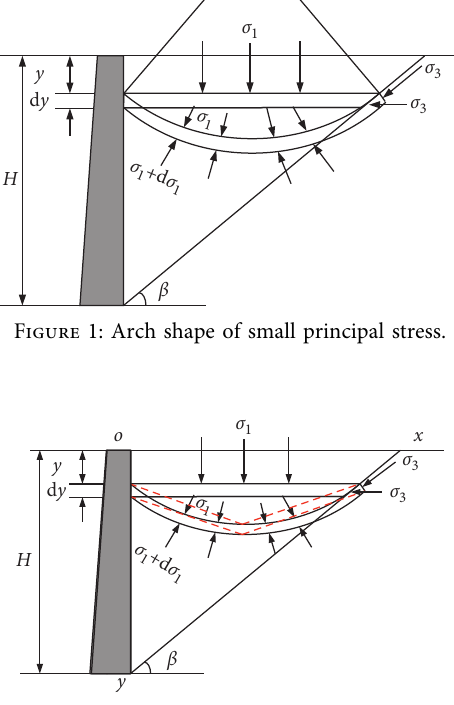
Figure 2: Simplification of small principal stress